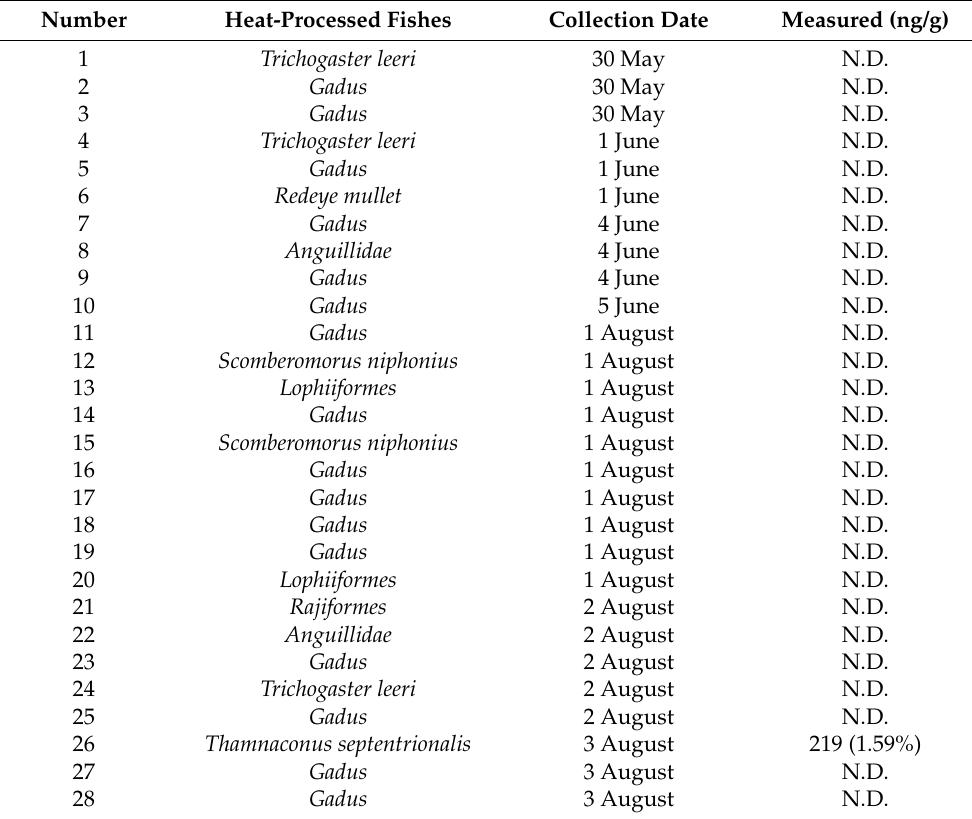
Table 6. Determination of TTX in different heat-processed fishes based on the established